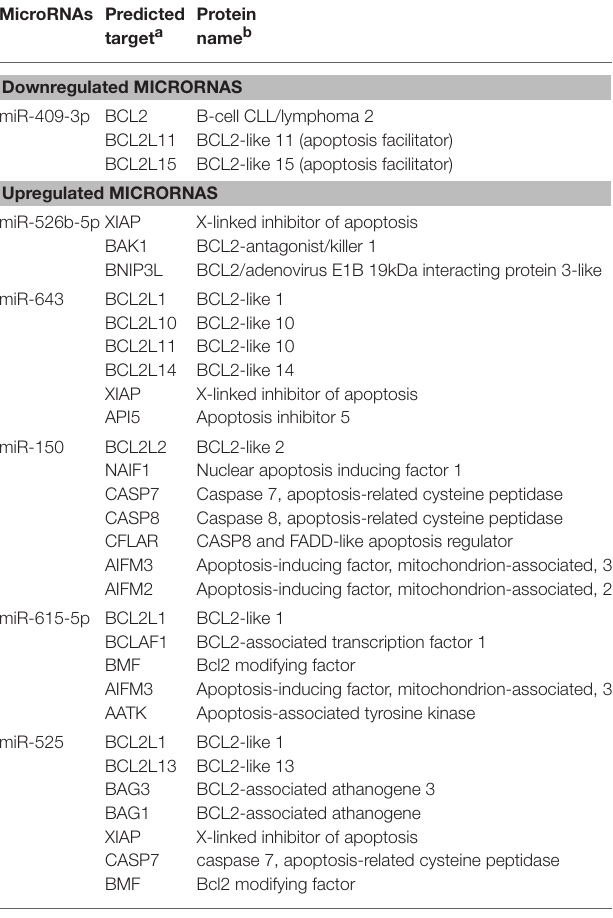
TABLE 3 | Modulated microRNAs in SW-480 cells interacting with E. histolytica for 45min and predicted targets associated to apoptosis. MicroRNAs Predicted target